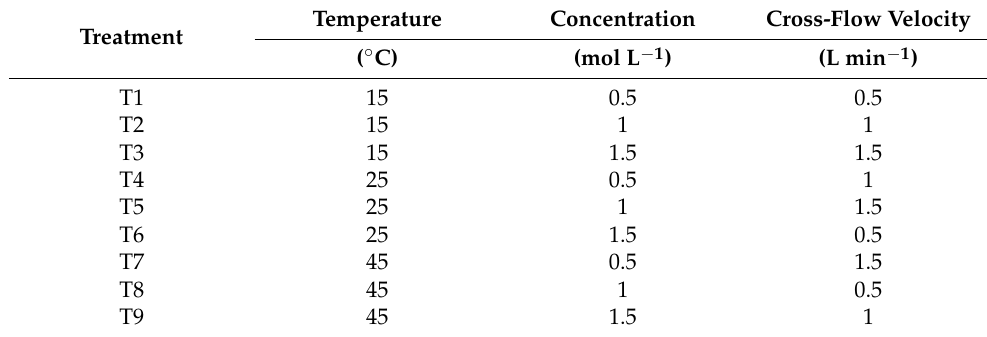
Table 1. Orthogonal experimental design of FO membrane concentration. Temperature Treatment